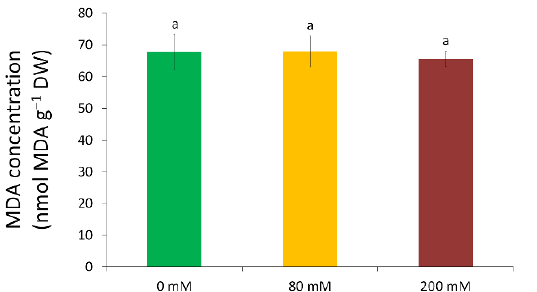
Figure 7. The MDA content of Arundo donax leaves expressed on a dry weight (DW) basis. Error bars represent SD values. To compare the differences, one-way ANOVA was performed on each dataset with Tukey’s post-hoc test on the treatments ( p < 0.05). Same lowercase letters indicate there are no significantly different groups.